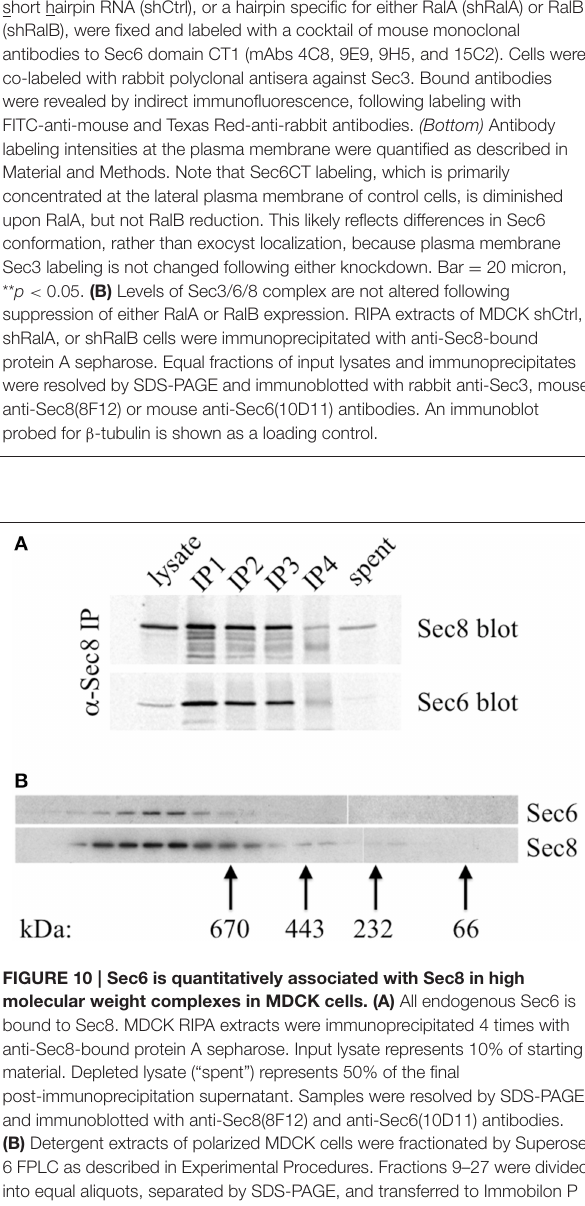
( Figure 7B ), confirming not only that Sec6 is the protein recognized by all of the mAbs on diverse structures, but also that this diversity in labeling is not caused by alternatively spliced Sec6 variants localizing to distinct subcellular